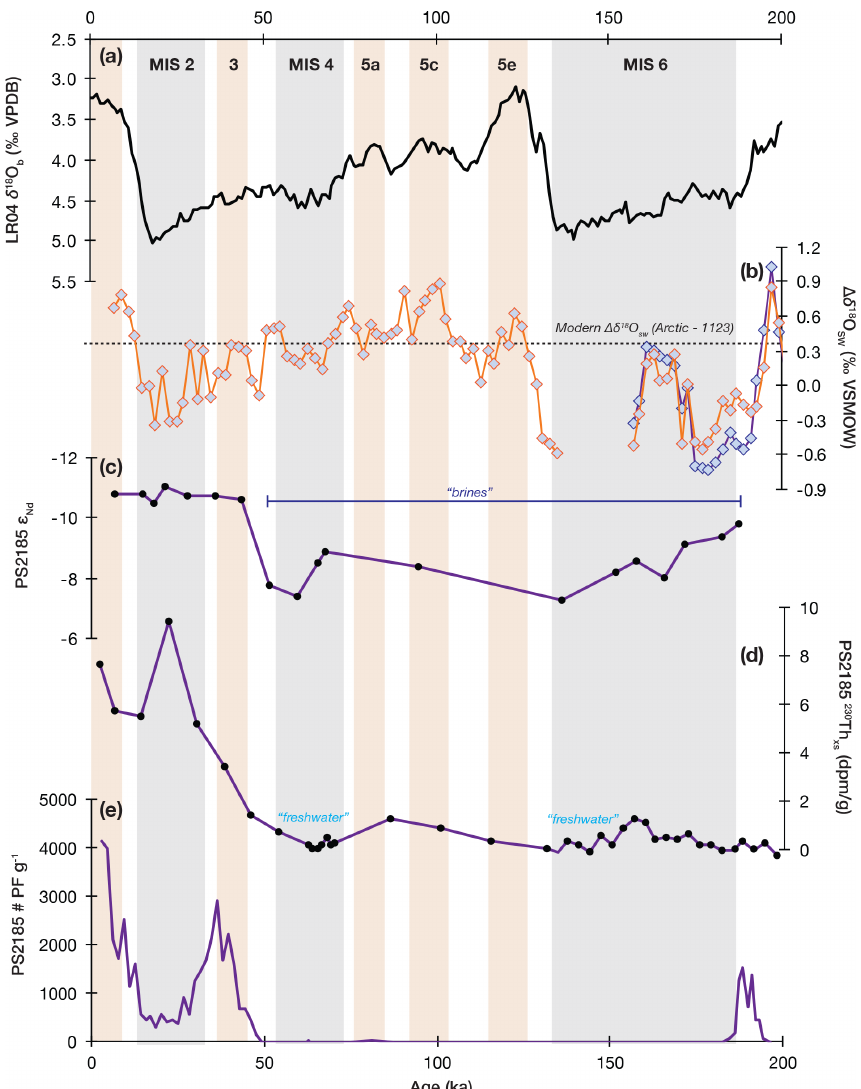
Figure 7. LR04 δ 18 O b stack ( a ; Lisiecki and Raymo, 2005), local intermediate-to-deep-Arctic δ 18 O sw from differencing Site 1123 (orange) and Site 607 (blue) ( b ; this study), central Arctic Site PS2185-3/6 metal oxide ε Nd ( c ; Haley et al., 2008), excess 230 Th ( d ; Geibert et al., 2021), and planktonic foraminifera abundance ( e ; Spielhagen et al., 2004). The age model for the PS2185-3/6 data (c–e) was based on aligning low excess 230 Th to MIS 4 and 6 as proposed by Geibert et al. (2021). High ε Nd (plotted downward) is argued to represent increased input of Siberian weathering products to the intermediate Arctic Ocean, presumably via brine formation on the Eurasian shelves (Haley et al., 2008). Gray shading indicates glacials MIS 2, 4, and 6; orange shading indicates interglacials MIS 1, 3, and 5a, 5c, and